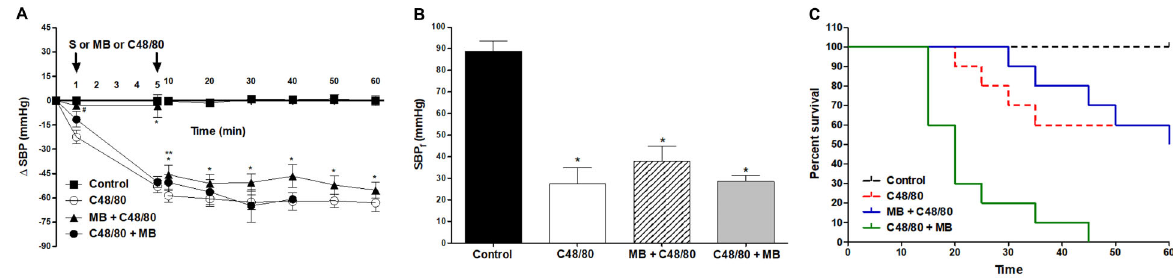
Figure 3. A , Systolic blood pressure (SBP), B , fi nal systolic blood pressure (SBP f ), and C , survival measurements of rats that received C48/80 and/or MB (Kaplan-Meier, n=6). Data are reported as mean ± SE. A : *P o 0.001 MB + C48/80 vs control; **P o 0.001 MB +